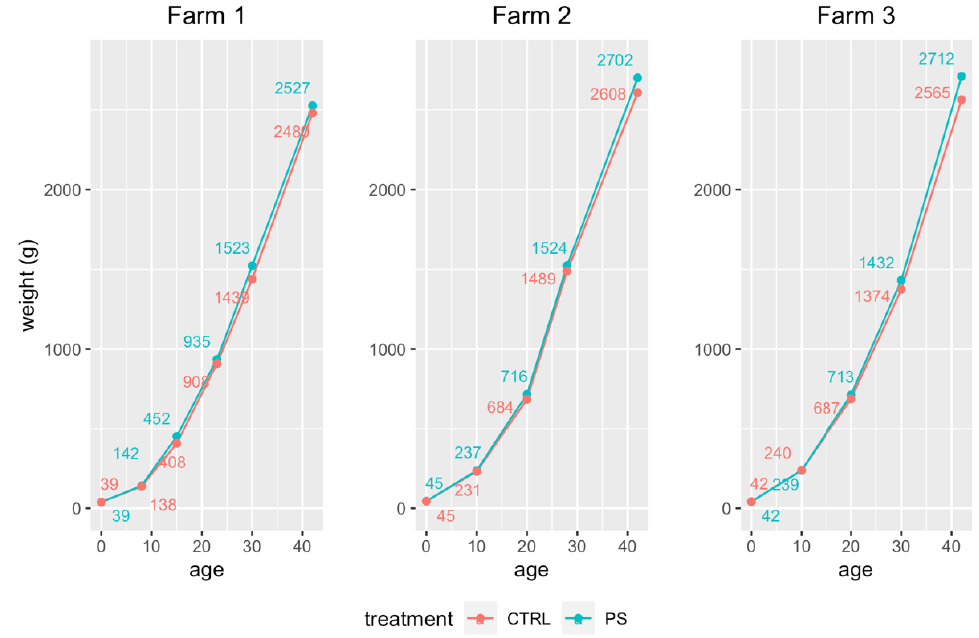
Figure 2. Live BW progression in synbiotic-treated (PS) and control chickens (CTRL). Table 3. Average carcass weights and feed conversion ratios (FCRs) measured in treated and control houses of the three farms. p -values below 0.05, marking the statistical significance of a difference observed when comparing treatment and control groups, are underlined.